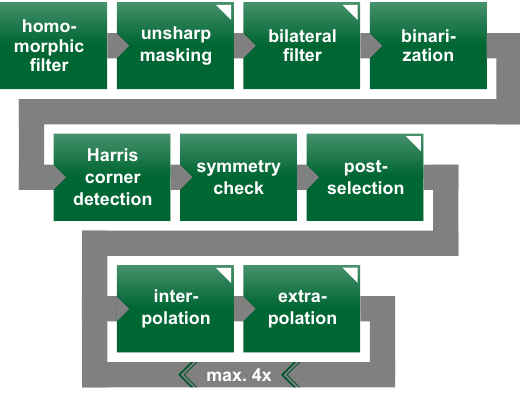
Figure 9. Flowchart of the calibration process. White corners indicate new processing